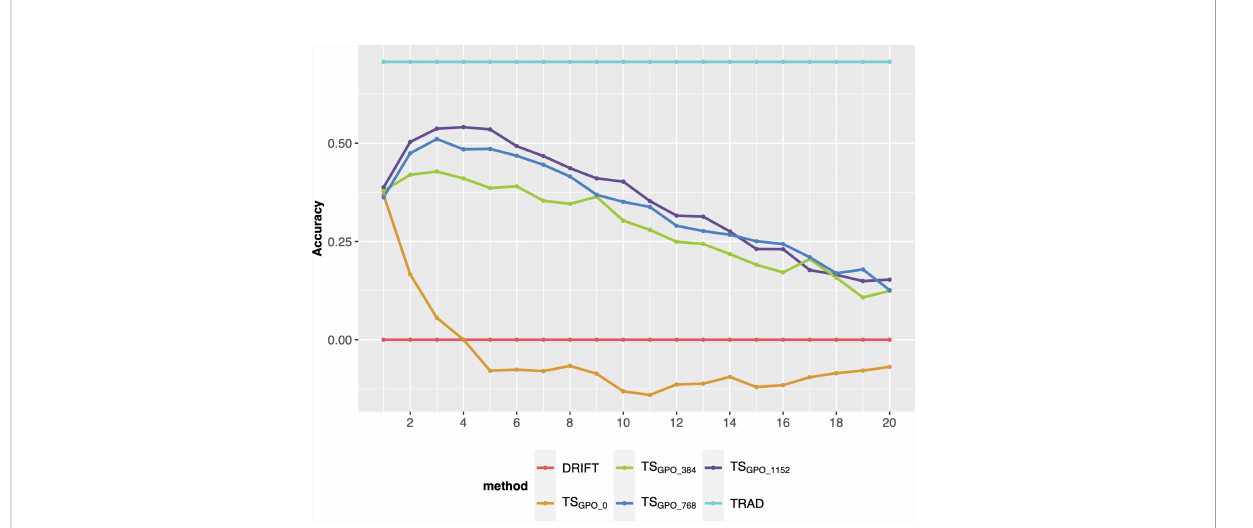
FIGURE 5 Prediction accuracy of selection over 20 breeding cycles via GS F2 S F4 scheme considering 48 parental lines, the TS GPO method, and different sample sizes to update every cycle ’ s training set. Each colored line represents an updating training sample size. TS GPO : training set built with the three last generations and updated each cycle; 0, 384, 768, and 1152 are the number of individuals used to update the